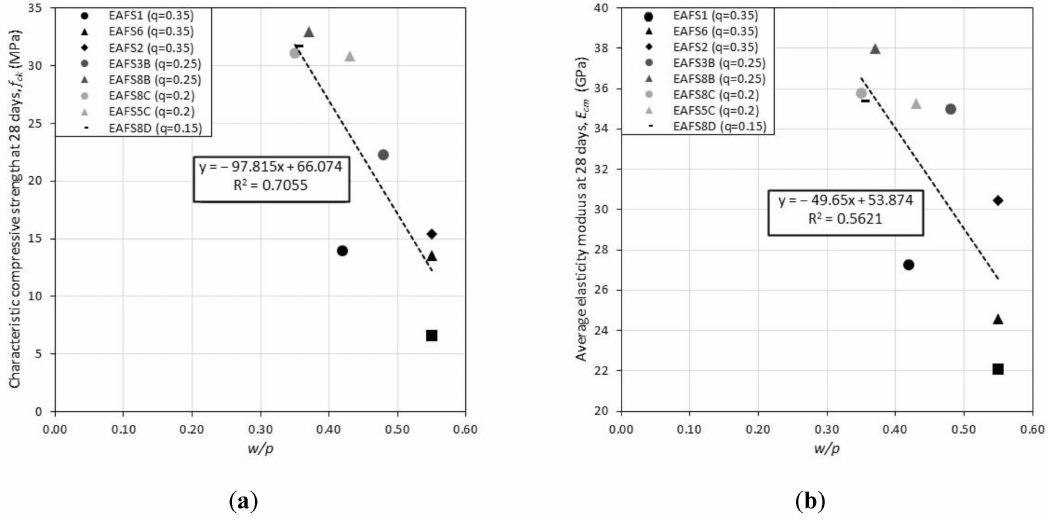
Figure 17. Evolution of the mechanical behavior with respect to the water/powder ratio, w / p , at 28 days: ( a ) characteristic compressive strength, f ck ; ( b ) average elasticity modulus, E cm .